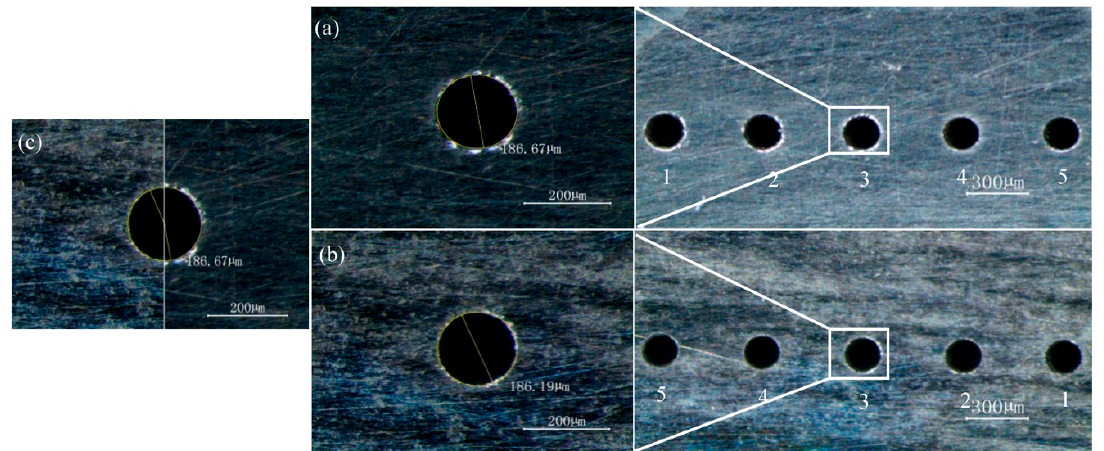
Figure 8. Micro array holes with no taper: ( a ) entrance; ( b ) exit; and ( c ) comparison of entrance and exit.